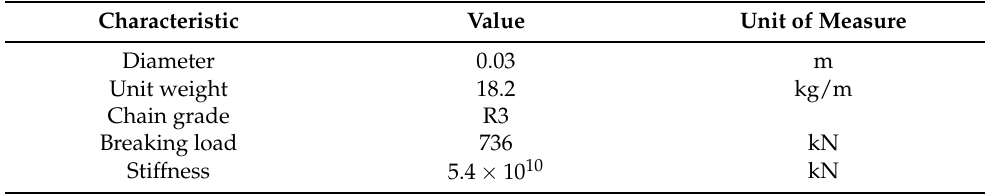
Table 3. Properties of the mooring system.